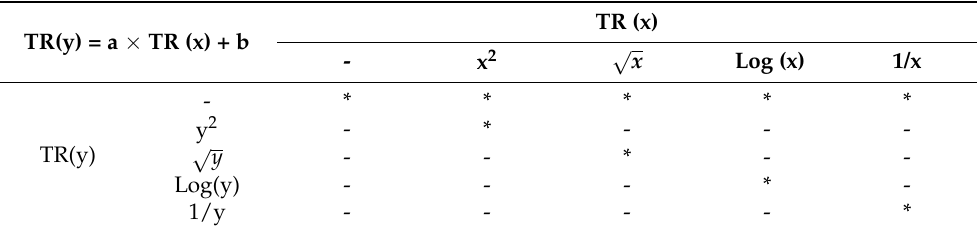
Table 1. Tested regression models and transformation of variables (* means the combinations of the target and explanatory